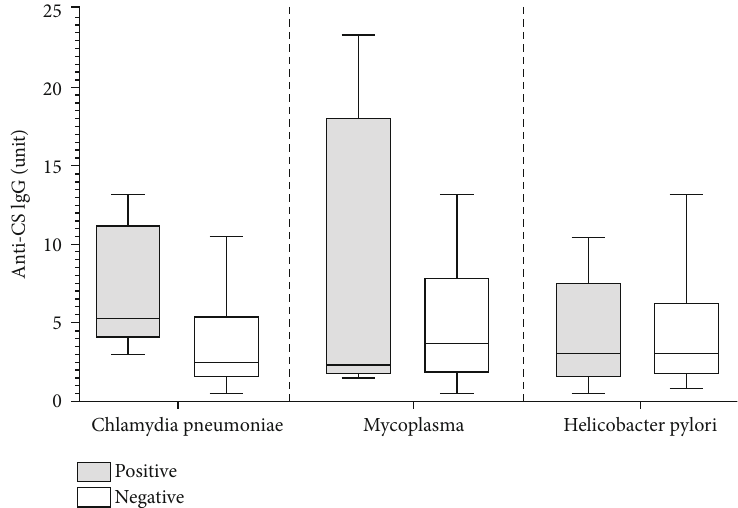
Figure 4: Natural IgG autoantibody levels in neuromyelitis optica spectrum disorder (NMOSD) and multiple sclerosis (MS) patients positive or negative for the investigated antibacterial IgG antibodies. Anti-citrate synthase (CS) IgG antibody levels in anti-Chlamydia pneumoniae, anti-Mycoplasma pneumoniae, and anti-Helicobacter pylori IgG-positive and IgG-negative NMOSD and MS patients, as measured by ELISA. Boxes show interquartile ranges (IQR); whiskers indicate the lowest and highest values; horizontal lines represent medians; n NMOSD+MS = 25